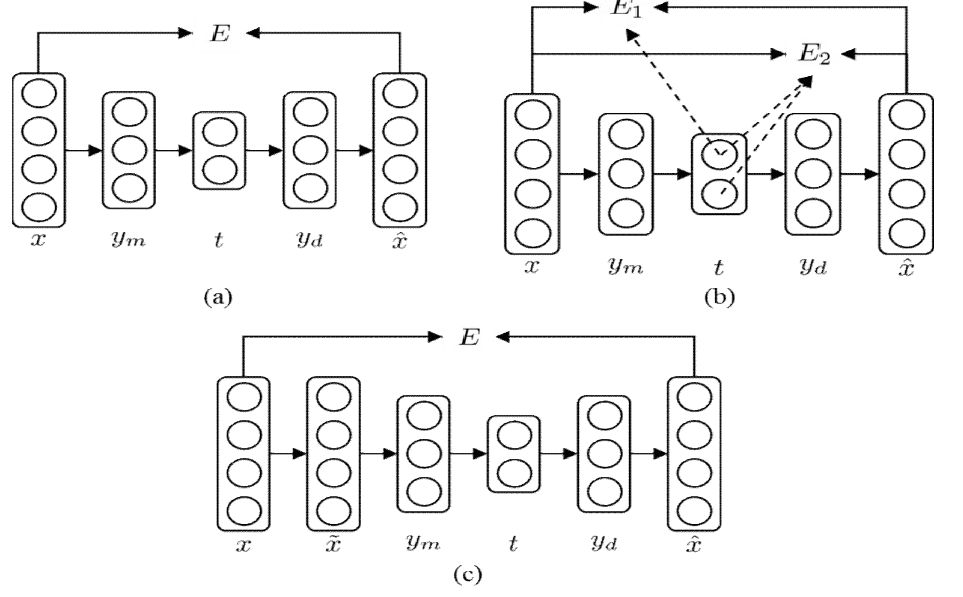
Figure 3. Schematic representation of different objective functions: ( a ) reconstruction error; ( b ) hierarchical error; ( c ) denoising criterion.